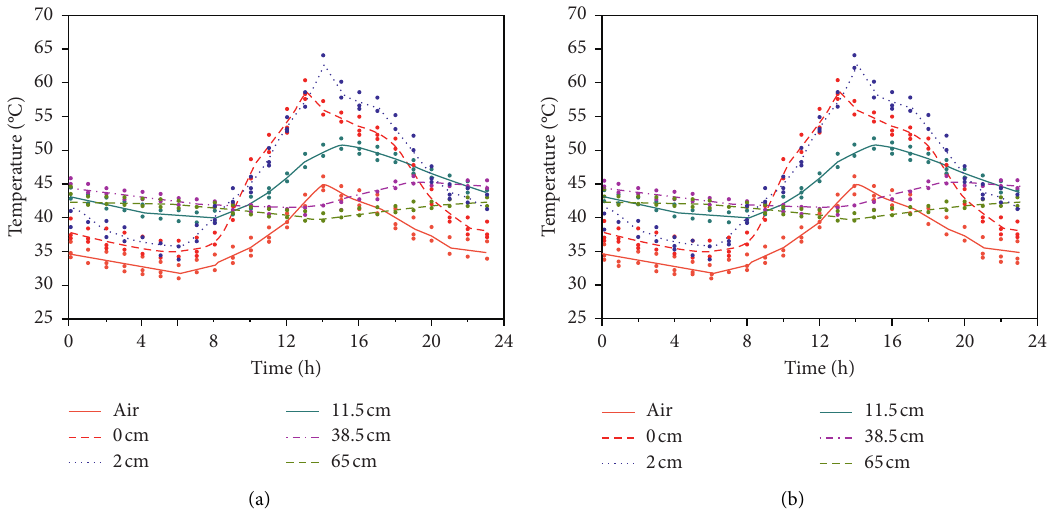
Figure 5: Air and pavement temperature profile over time in summer: (a) Site 1. (b) Site 2.